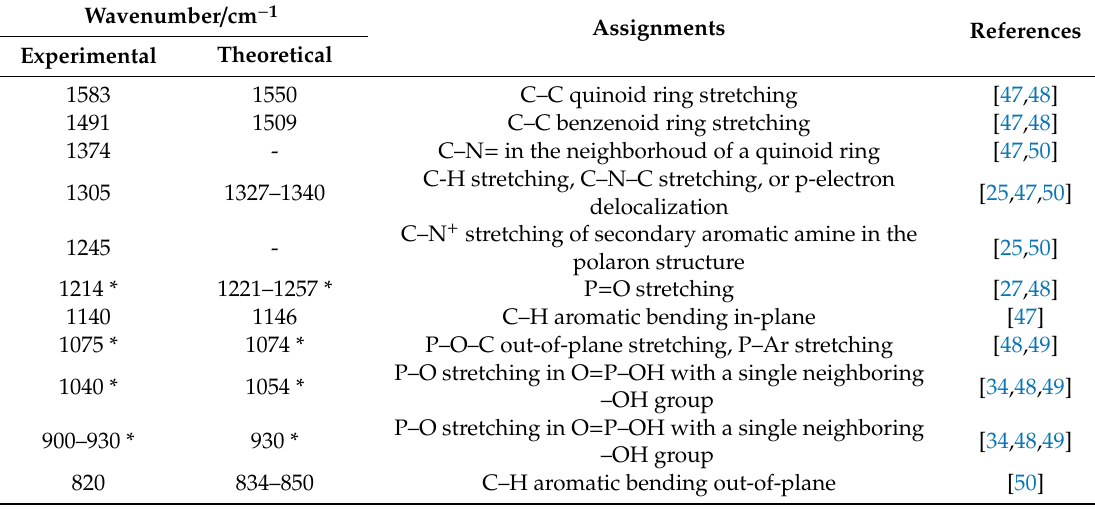
Table 3. Chemical composition and atomic ratios obtained from the XPS spectra of PANI, PANI2APPA, and PANI4APPA samples. Percentages are referred to the respective atomic